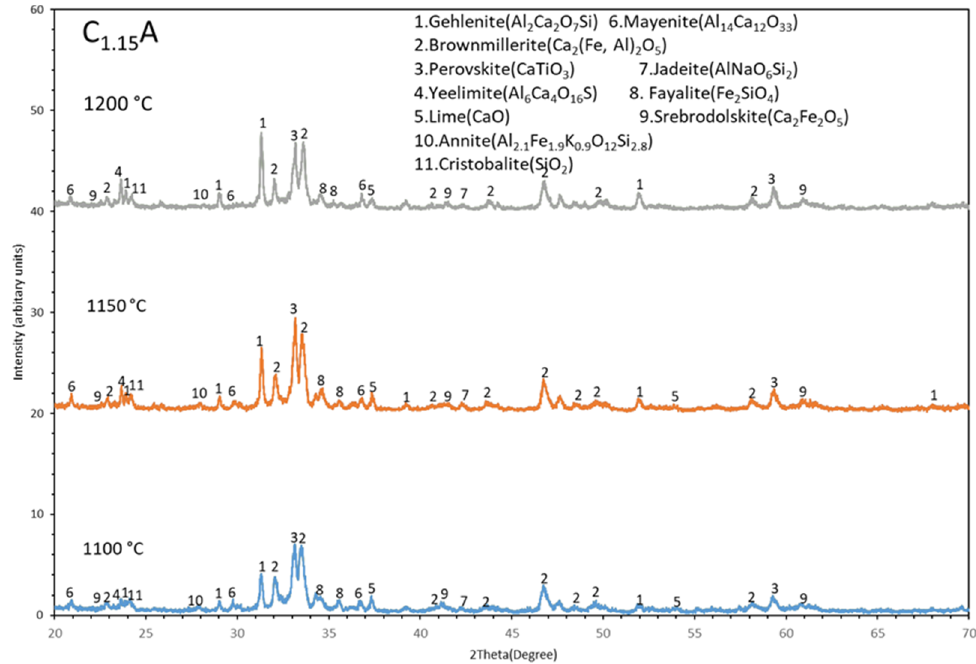
Figure 6. XRD patterns of the C 1.15 A oxide pellets at different sintering temperatures.